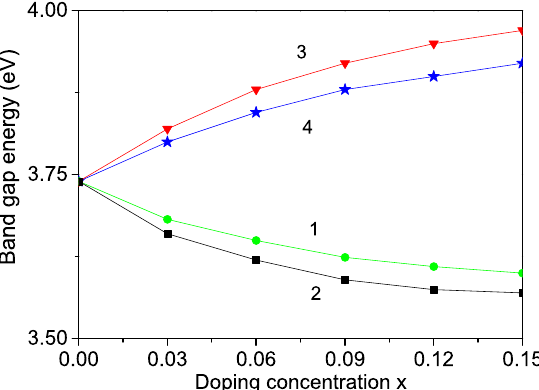
Figure 9. Doping concentration dependence of the band gap energy E g of a ZnS NP for N = 10 shells, T = 300 K and different doping ions: (1) Fe; (2) Co; (3) Y; (4)